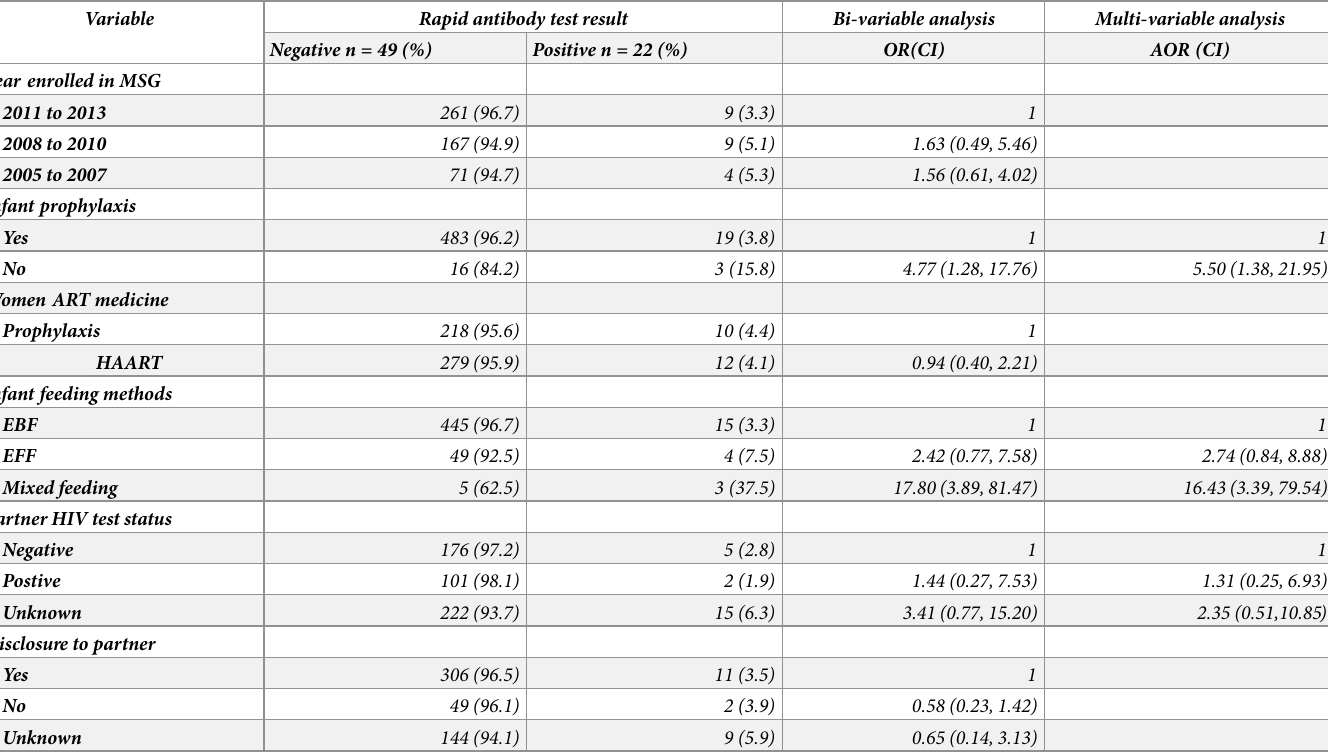
Table 3. Predictors of HIV positive antibody test among HIV exposed babies followed in MSG programmes in Addis Ababa from 2005 to